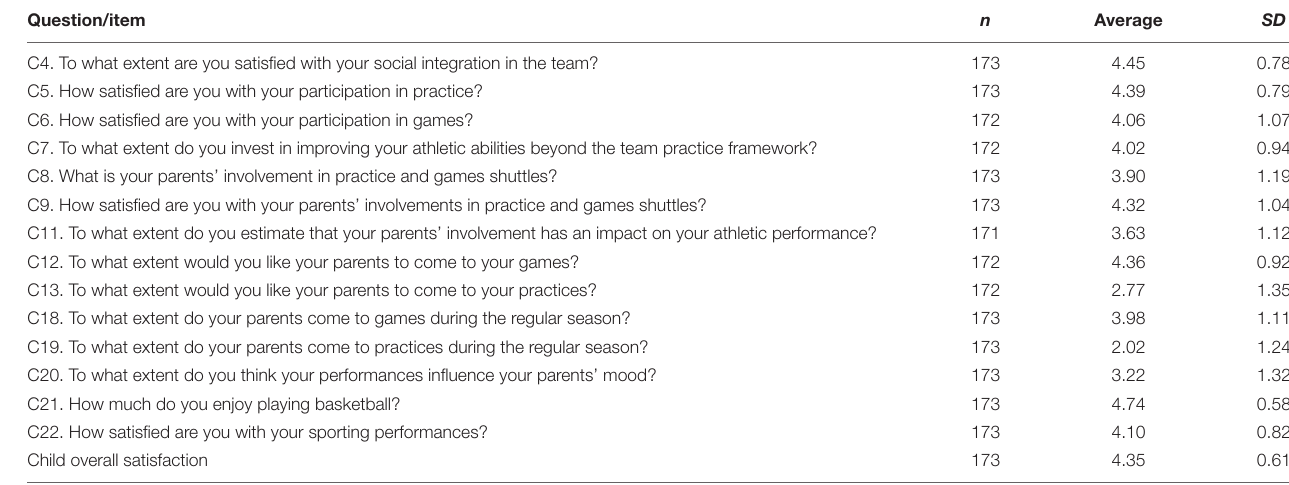
TABLE 2 | Descriptive statistics for young basketball players’ (C)